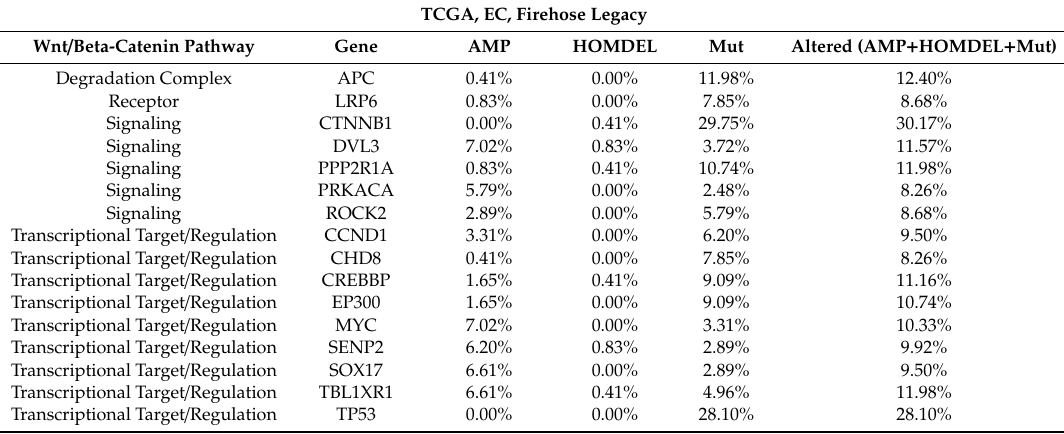
Table 2. Canonical and non-canonical Wnt / β -catenin signaling pathway alterations in Uterine Corpus Endometrial Carcinoma. The Cancer Genome Atlas (TCGA), Firehose Legacy. Wnt / β -catenin